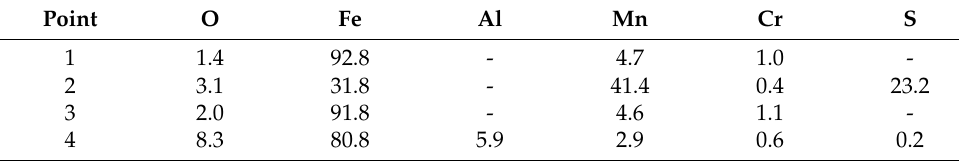
Table 4. 1.5Al-3Mn-HT steel, results of EDS analysis of the corrosion spot in wt.%.